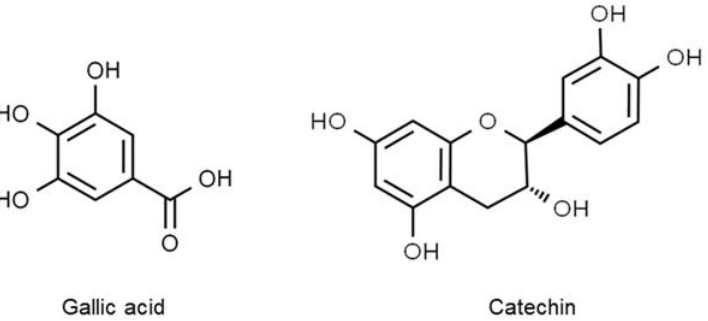
Figure 1. The structures of the most common polyphenols. Gallic acid, C 7 H 6 O 5 ( left ), belongs to the phenolic acid class, whereas catechin, C 15 H 14 O 6 ( right ), is part of the flavonoid class.